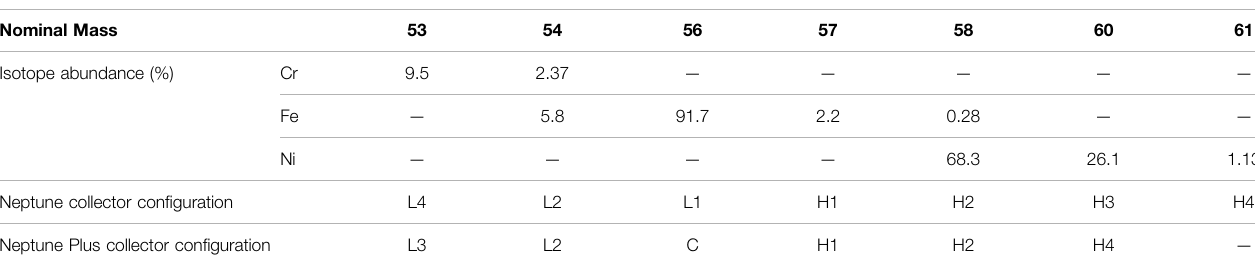
TABLE 2 | Faraday cup con fi guration and isotopic abundances for Fe, Cr, and